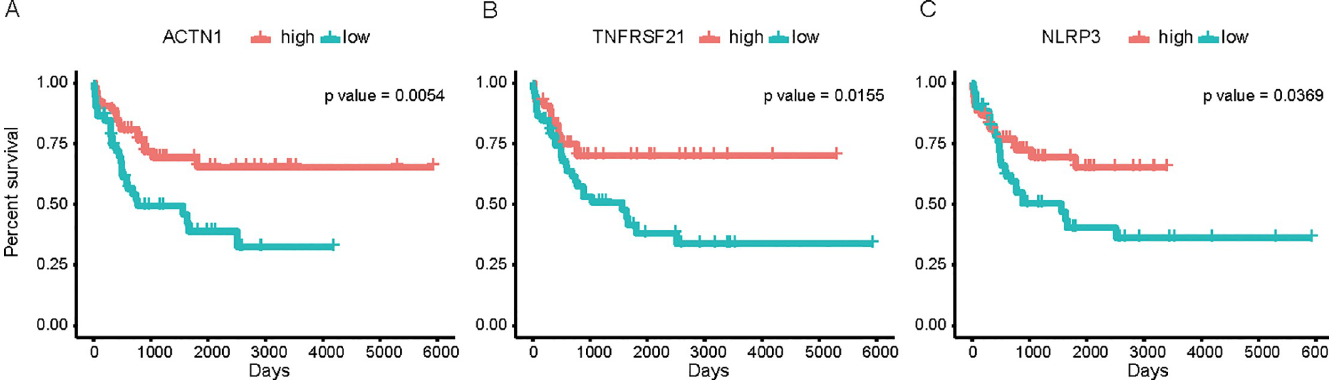
Fig 6. The survival analysis of ACTN1, TNFRSF21 and NLRP3 in patients with ALL. Kaplan-Meier curves for (A) ACTN1, (B) TNFRSF21 and (C) NLRP3. Samples with high expression and low expression of genes were plotted followed by univariate log-rank test. P-values equal to 5.4 × 10 − 3 , 1.55 × 10 − 2 and 3.69 × 10 − 2 , respectively.